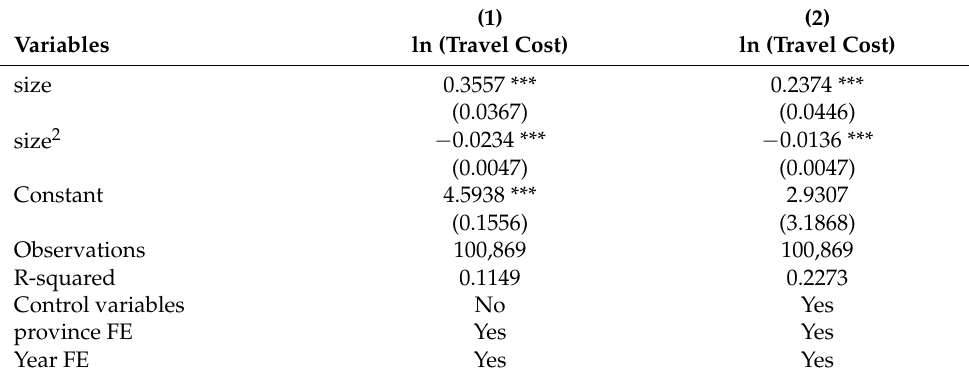
Table 8. The nonlinear regression